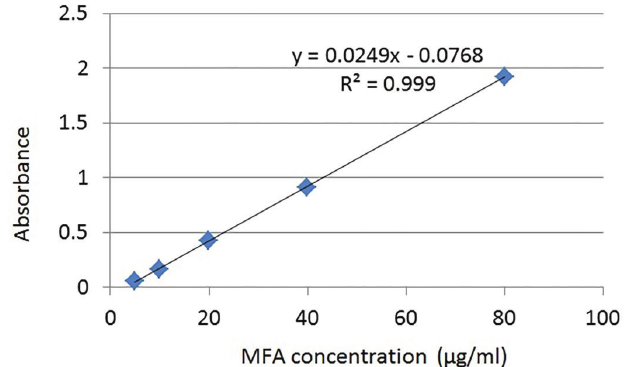
FIGURE 2 - Mefenamic acid calibration curve constructed via standard solution with five concentrations in the range from 5-80